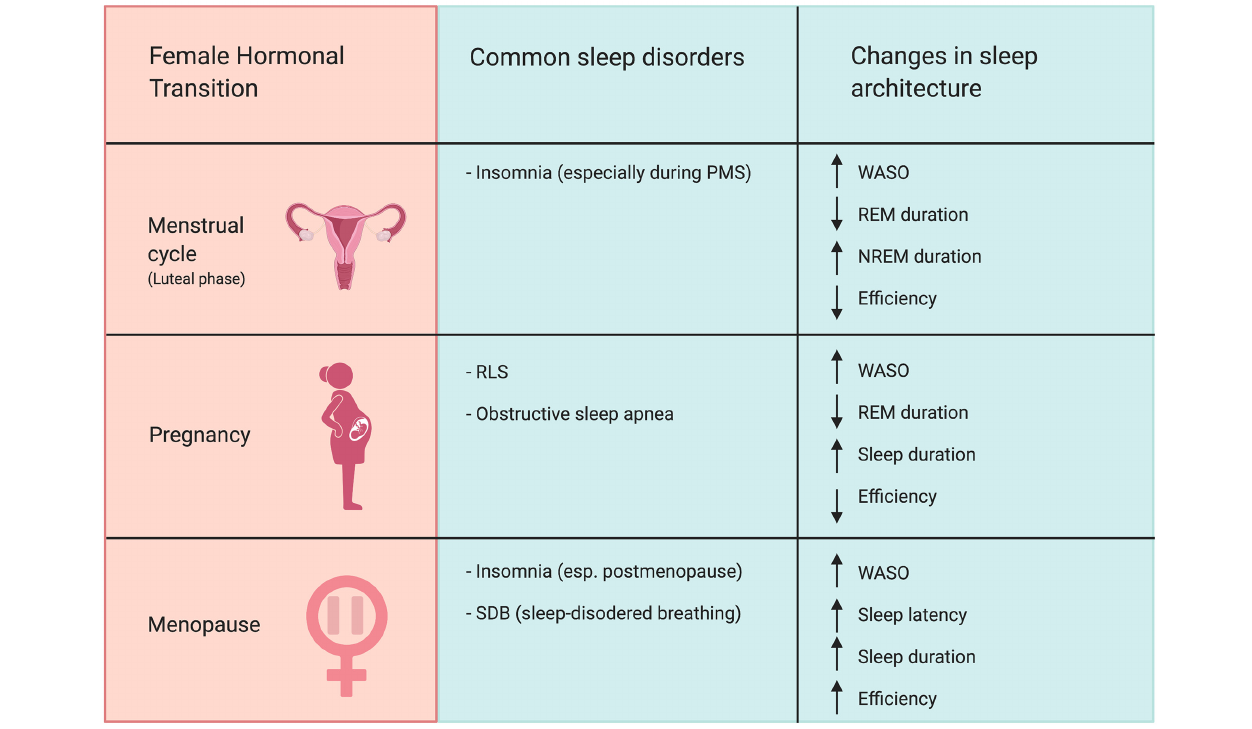
and progesterone peaks early in the dark phase (Smith et